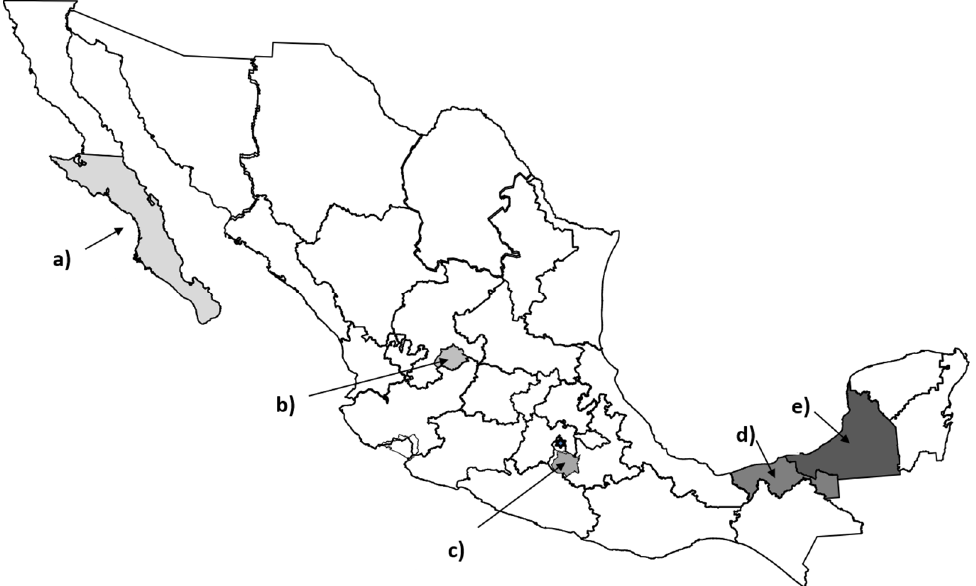
Figure 1. Participating states: ( a ) Baja California Sur, ( b ) Aguascalientes, ( c ) Morelos ( d ) Tabasco and ( e ) Campeche.